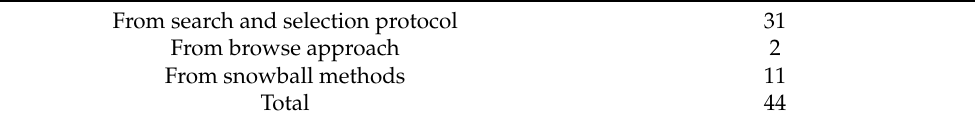
Table 4. Other paper sources used.